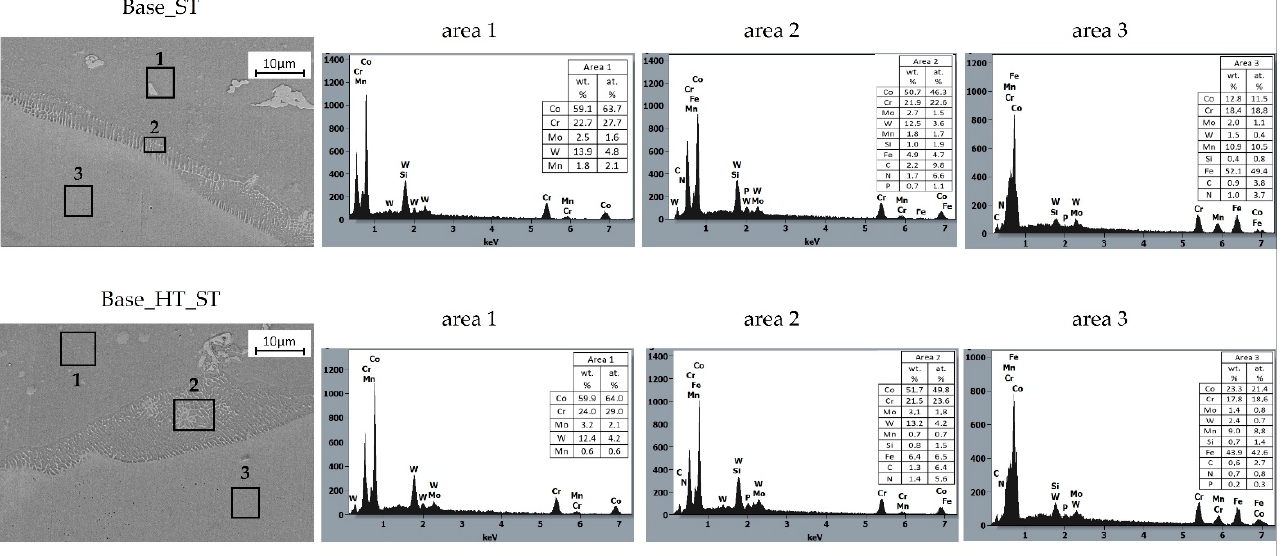
Figure 7. Microstructure and EDS analyses of CoCrMoW alloy welded with CoCr wire in as-welded conditions (Base_ST) and after heat treatment (Base_HT_ST).